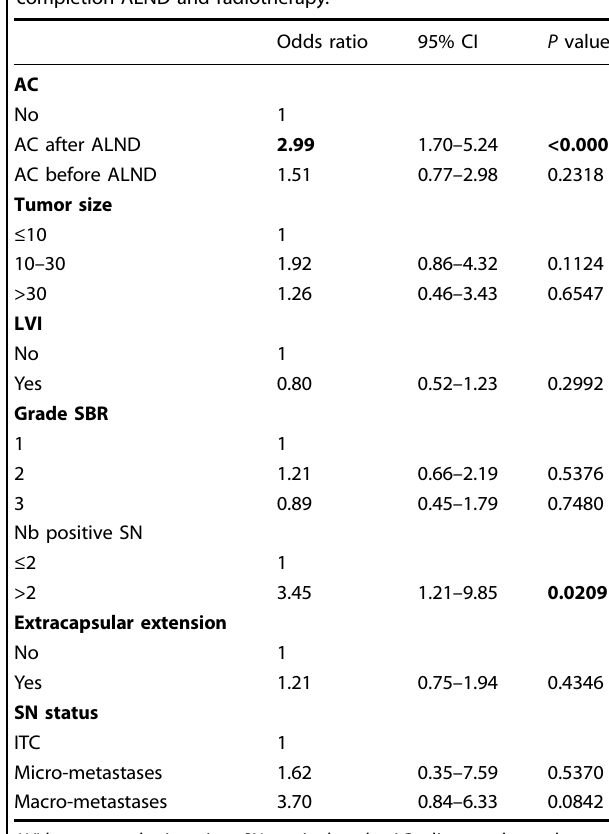
Table 3. Positive-NSN rates in multivariate analysis for patients with completion ALND and radiotherapy. Odds ratio 95% CI P